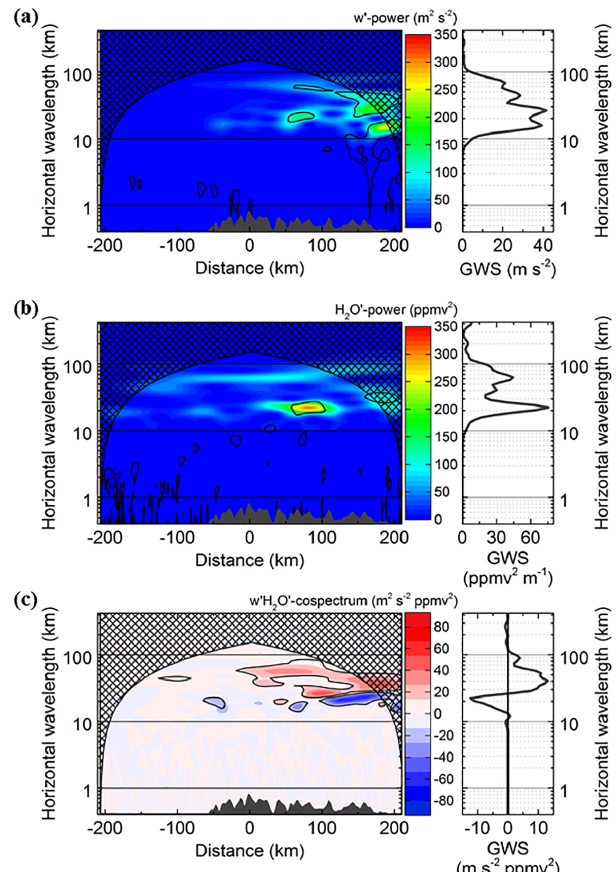
Figure 5. Wavelet analysis of the second flight leg of the DLR Fal- con flight FF04 shown in Fig. 2: (a) power spectrum of vertical wind perturbation w (cid:48) , (b) power spectrum of water vapor perturbation H 2 O (cid:48) and (c) cospectrum of the vertical water vapor flux w (cid:48) H 2 O (cid:48) . The right panels show the corresponding global wavelet spectrum (GWS). Thin black lines around colored areas are the 95% confi- dence level; the crosshatched area is the COI. The topography (max- imum mountain height of 2049m) is represented by the dark grey area in the bottom of each